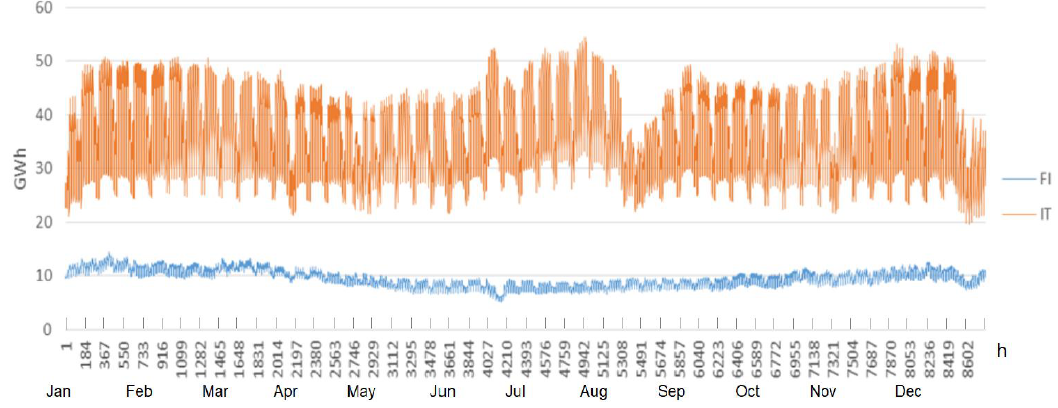
Figure 26. Electricity demand trend for Finland and Italy in 2013.